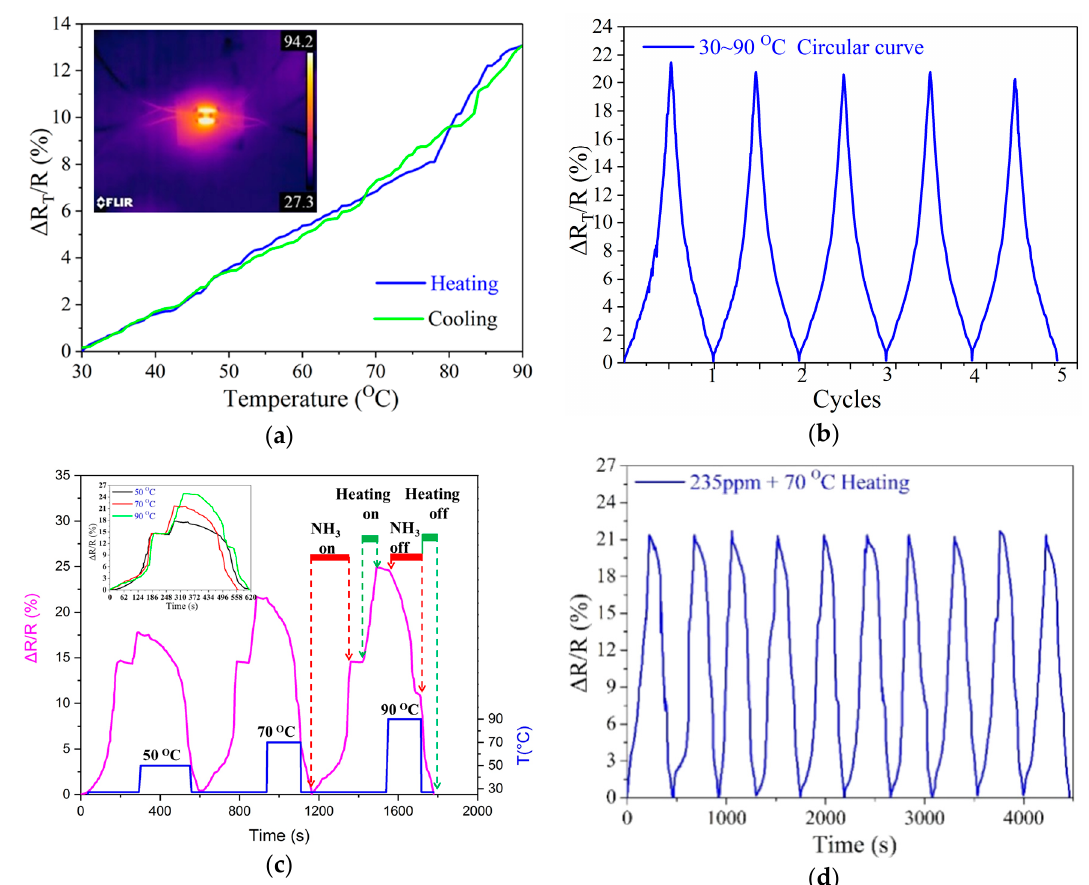
Figure 5. ( a ) The normalized resistance change of the graphene gas sensing element caused by thermal effect (heating and cooling); ( b ) Cycling response of the sensor to 235 ppm NH 3 gas during heating and cooling; ( c ) The normalized real-time resistance response/recovery behavior of the sensor to 235 ppm NH 3 at various desorption temperature from 50 to 90 °C; ( d ) Real-time cycling response of the sensor to 235 ppm NH 3 gas at 70 °C.